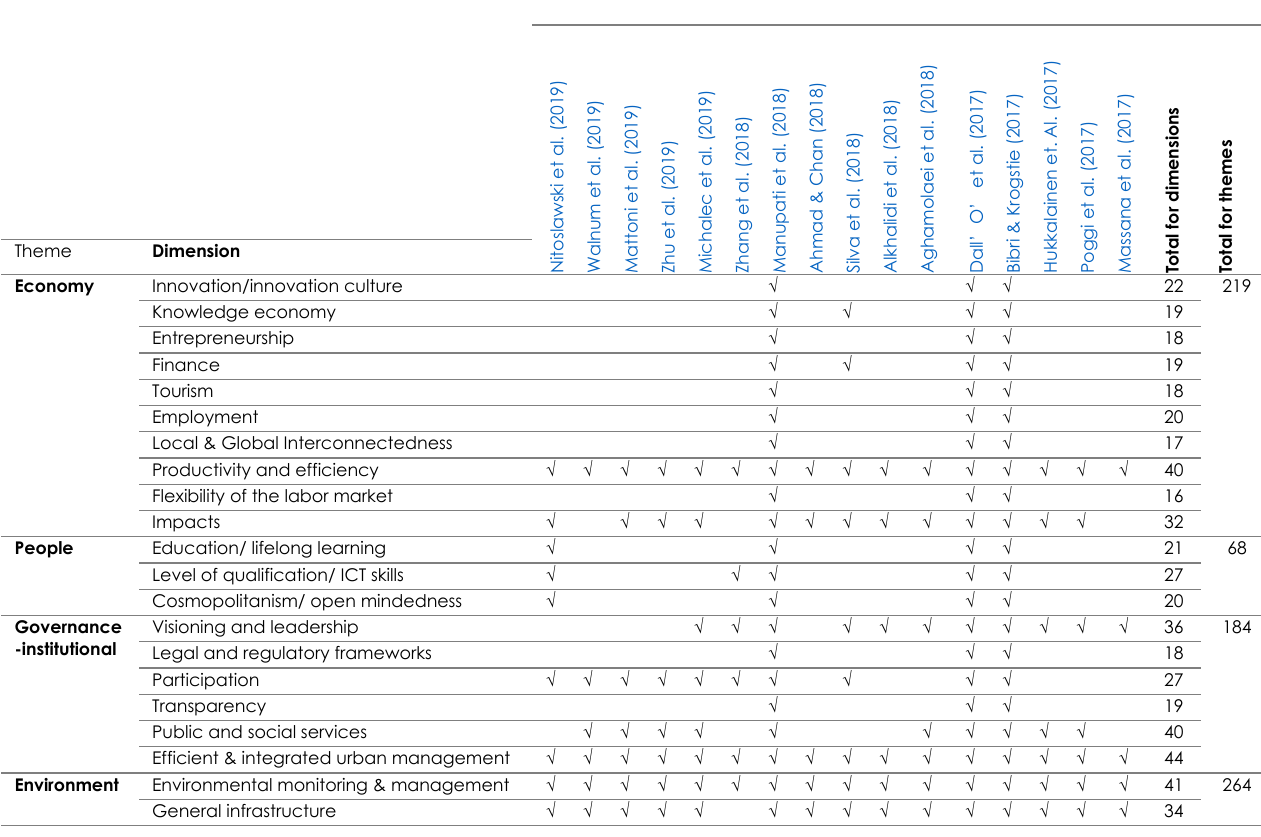
Table 5. Themes and Sub-themes of the reviewed papers in Urban Literature (continued). Sharifi (2019) Assessment Tools & KPIs for Smart